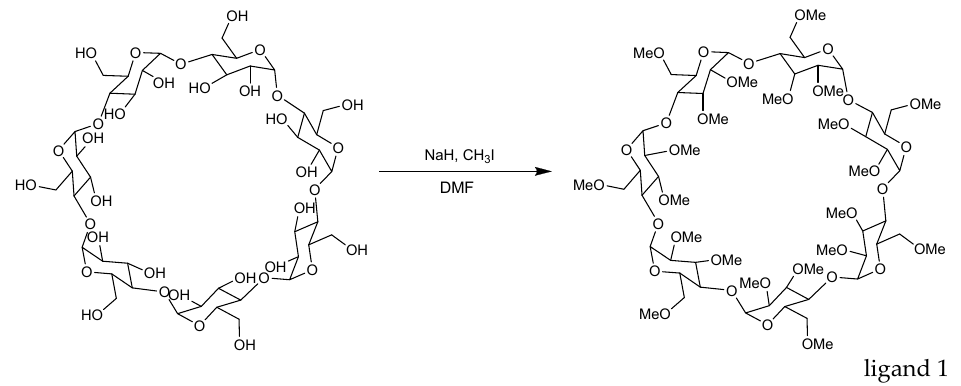
Figure 1. Methylation of β -CD .